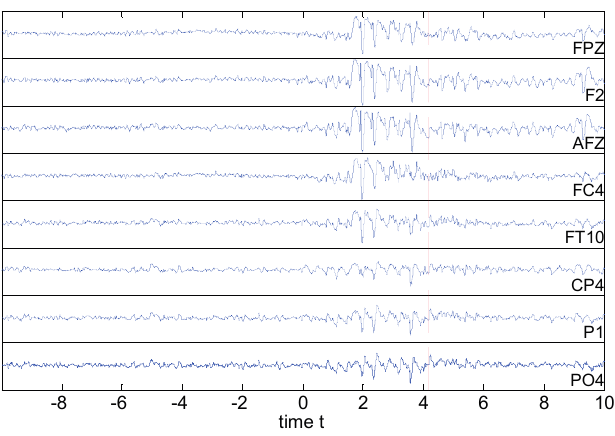
after the start (not shown).